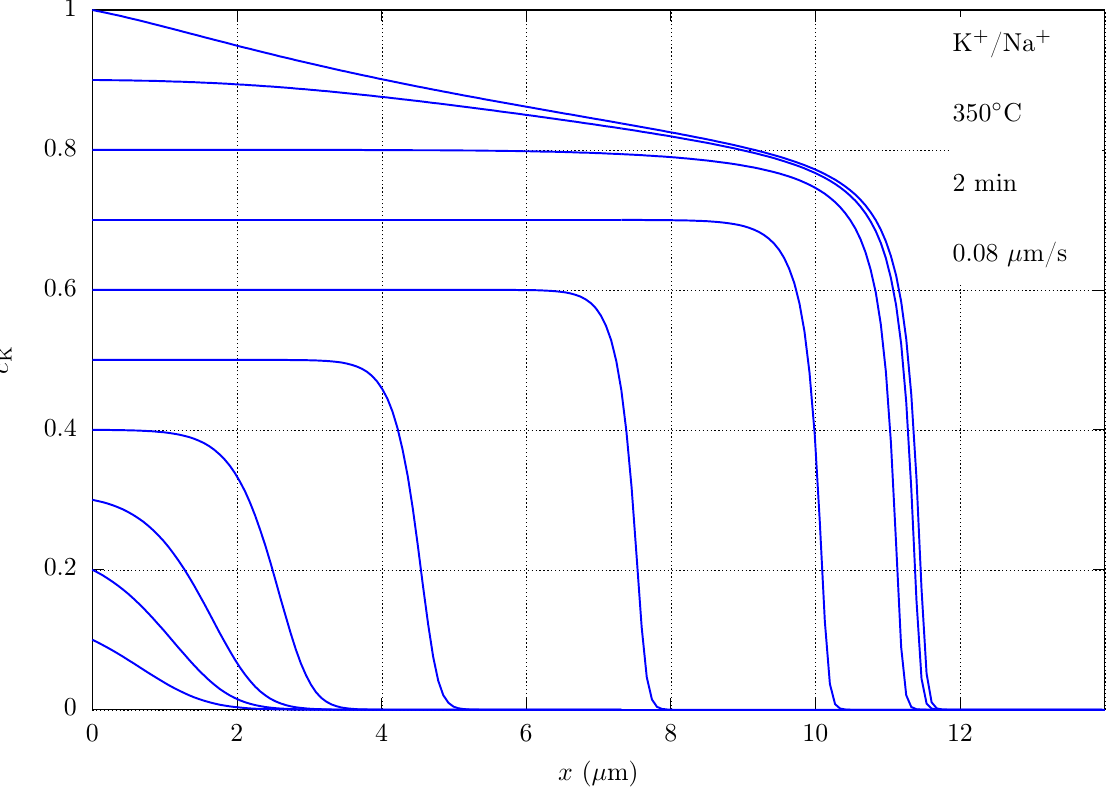
Figure 3. Simulation similar to that in Figure 2, but for a field-assisted IE with J 0 / C 0